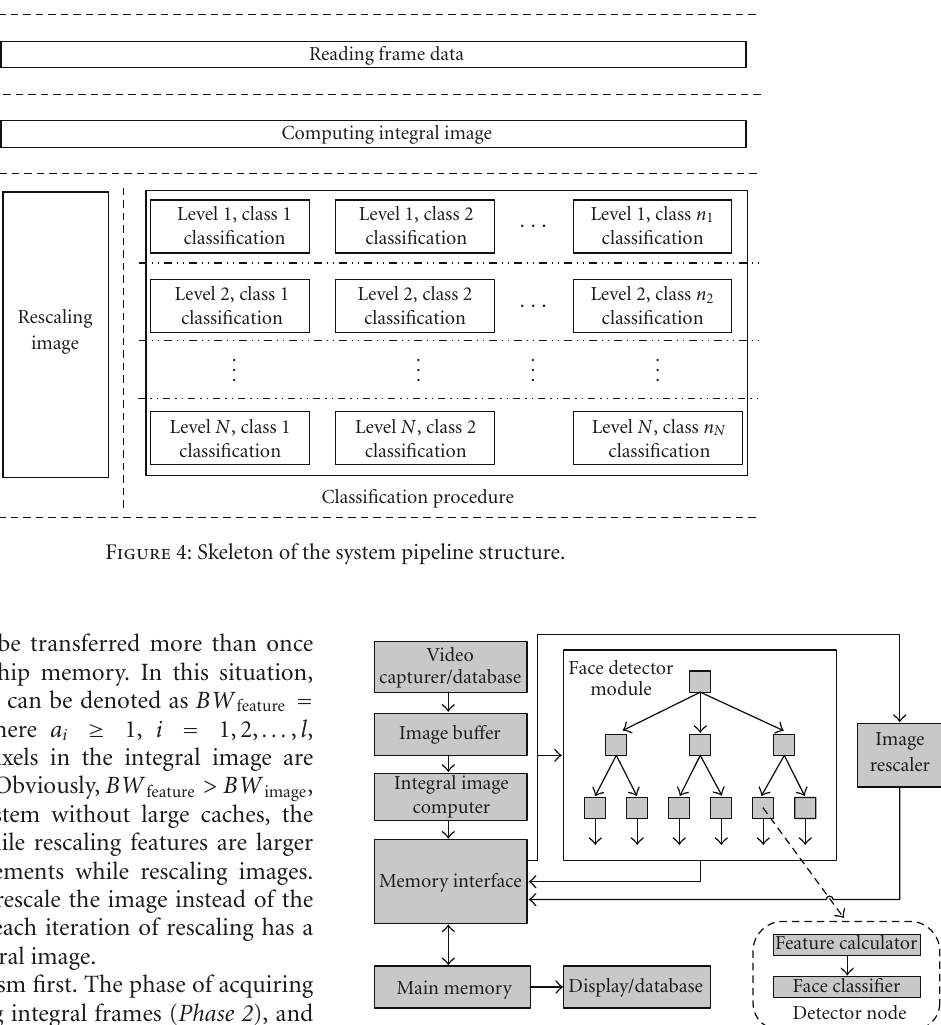
Figure 5: Global architecture of the RIMVFD